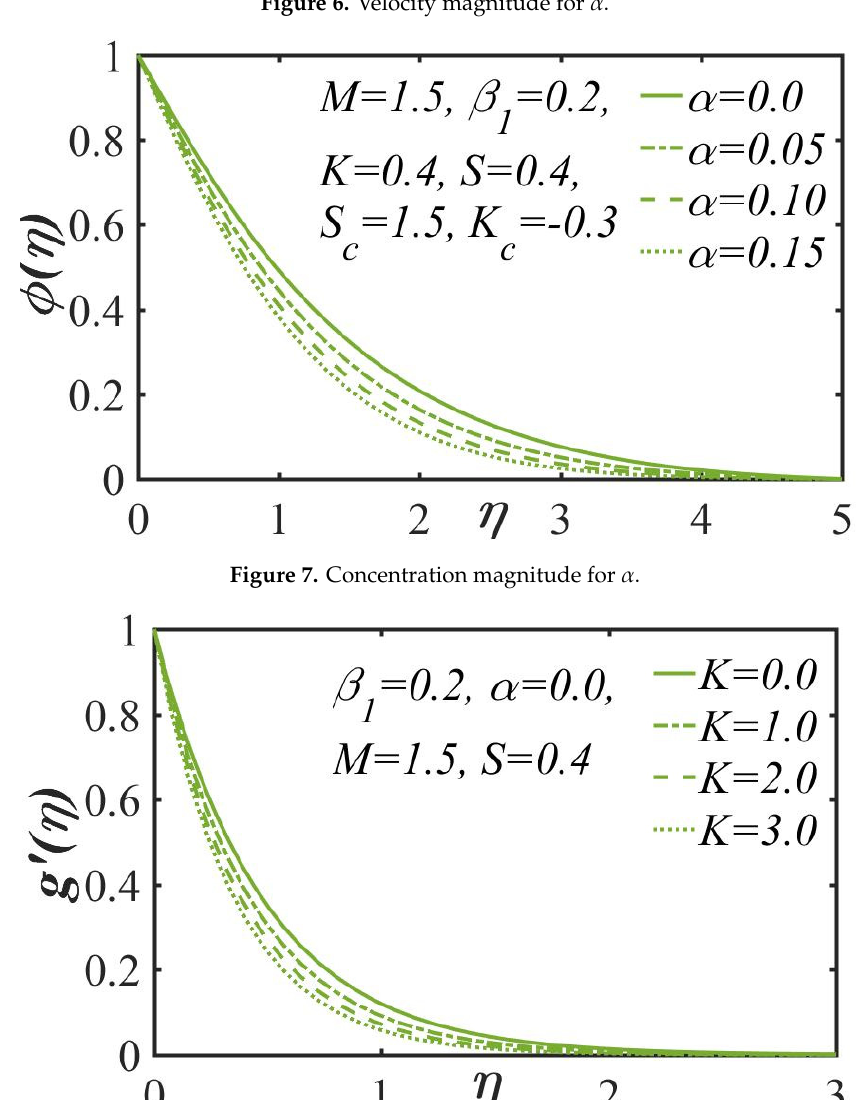
Figure 8. Velocity magnitude for (cid:1837) .